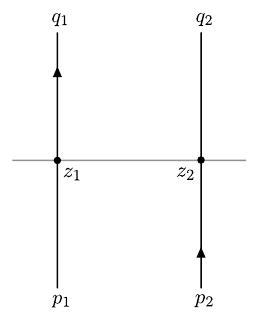
Figure 16. Tree-level contribution to (5.7) for p 1 ' q 1 and p 2 ' q 2